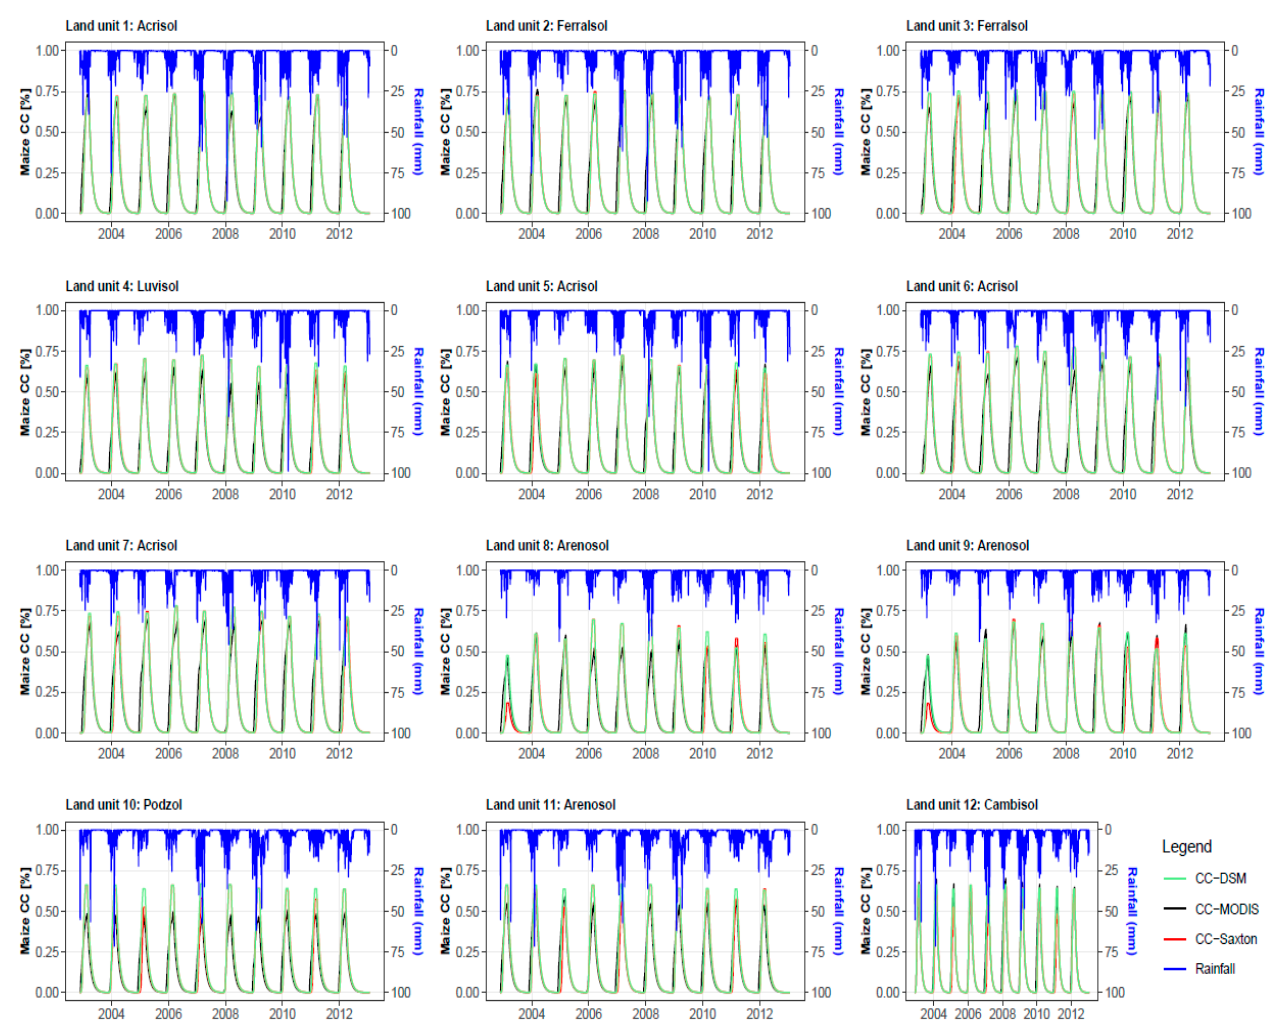
Figure 3. Comparison of the MODIS CC (black) time series with DSM CC time series (green), the Saxton CC (red) time series and the rainfall (blue) time series, for the 12 land units on the x -axis and for a simulation time period of (2002–2012) on the y -axis.